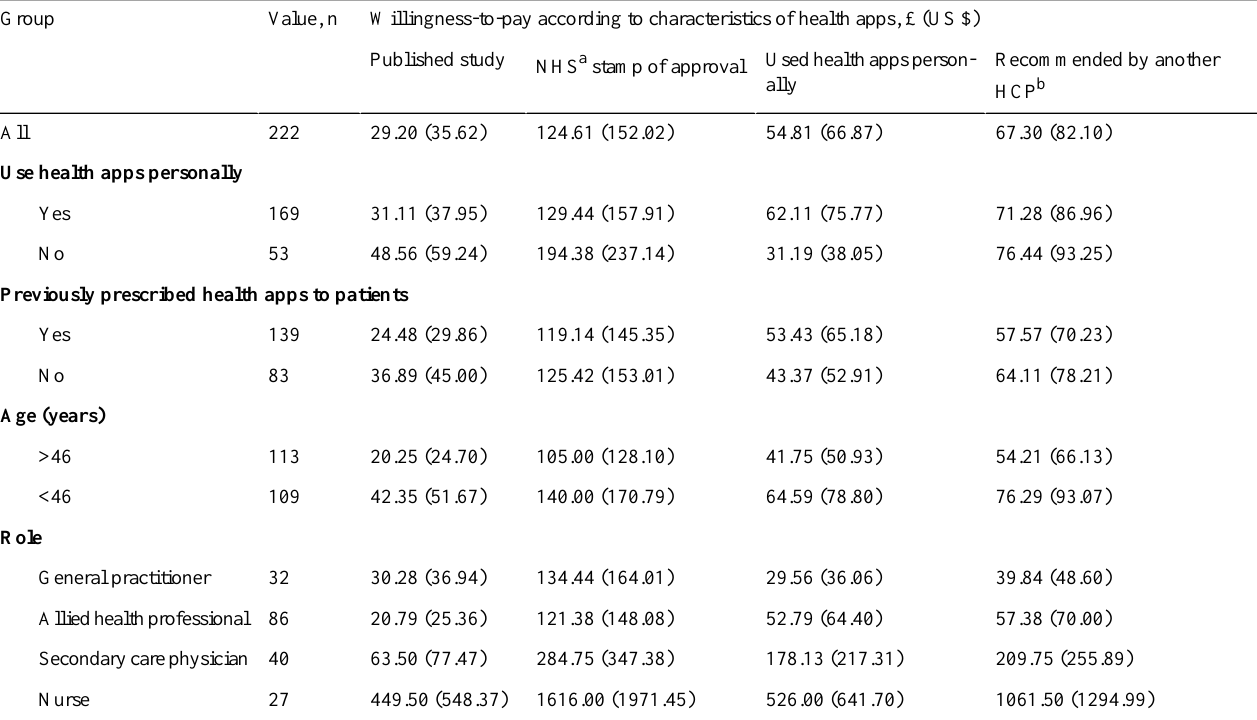
Table 5. Willingness-to-pay by health care professional subgroup.